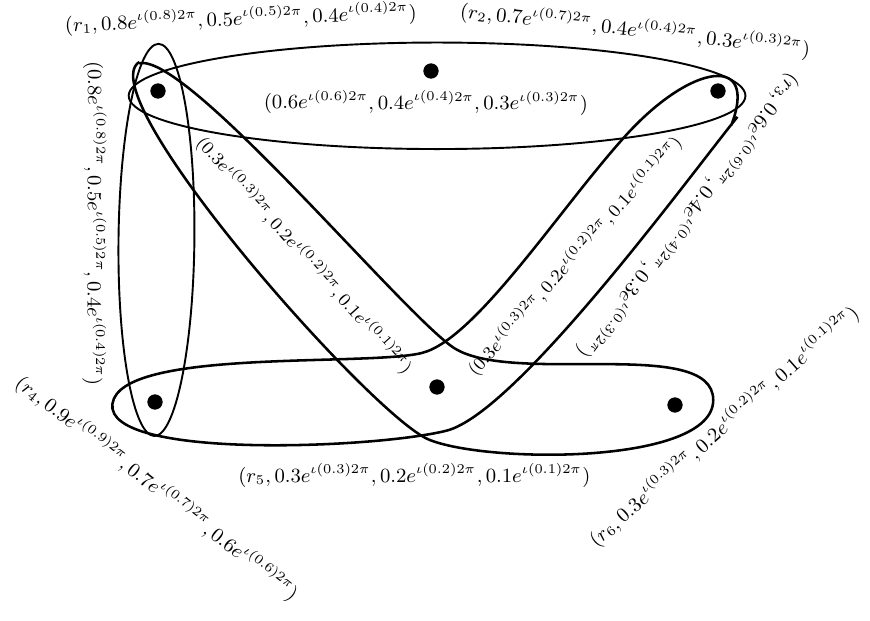
Figure 2. Complex neutrosophic hypergraph